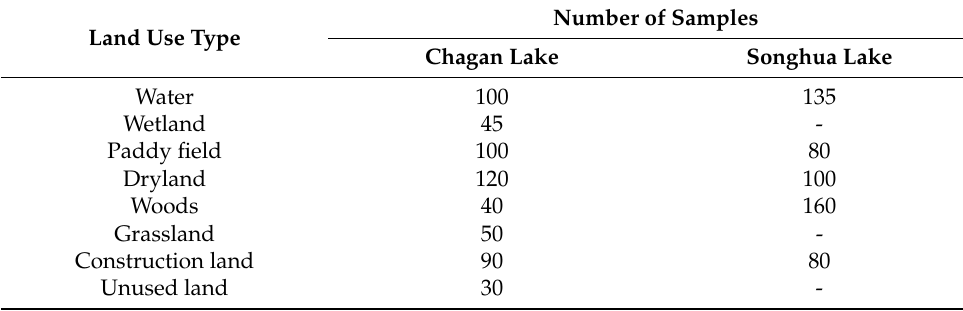
Table 3. The sample numbers of different land use types.